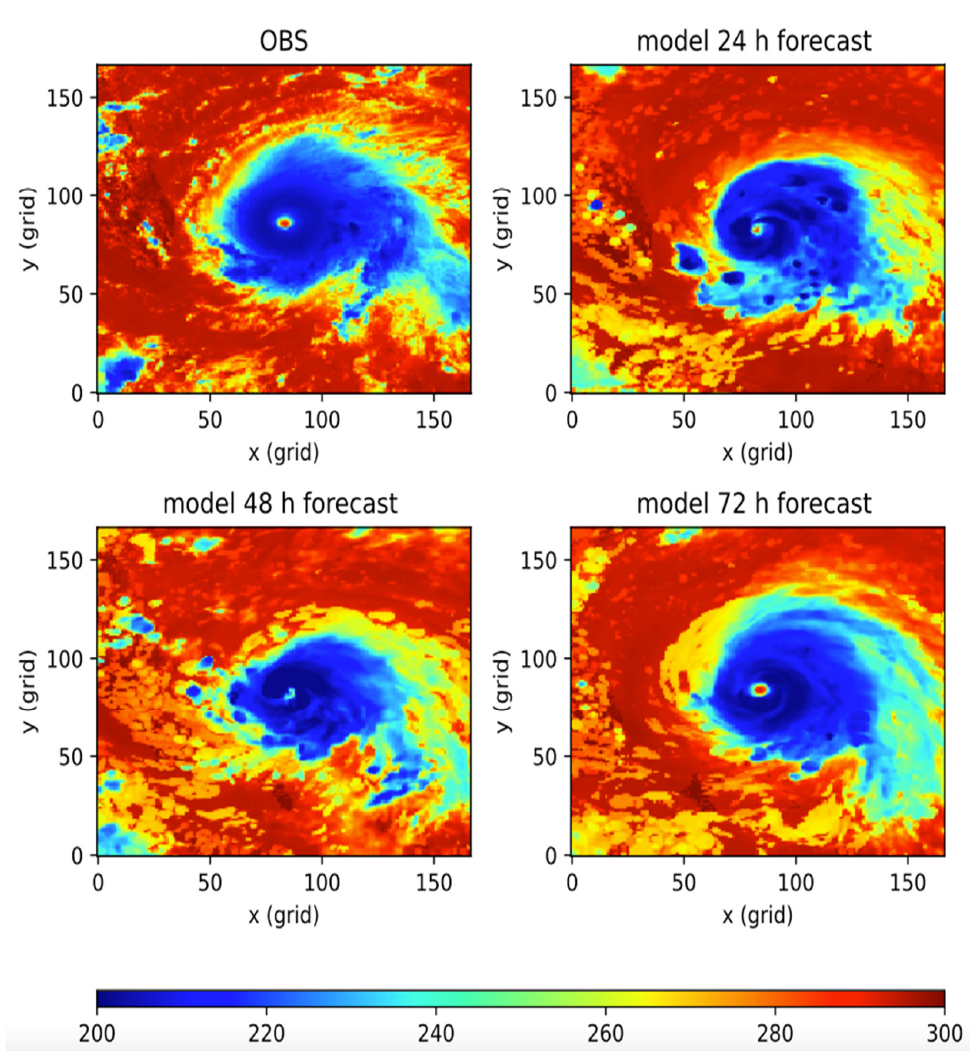
Figure 1. Observed GOES-R IR BT image of hurricane Dorian at 1 September 2019 18Z and model synthetic images at valid time of 1 September 2019 18Z with a lead time of 24, 48 and 72 h.